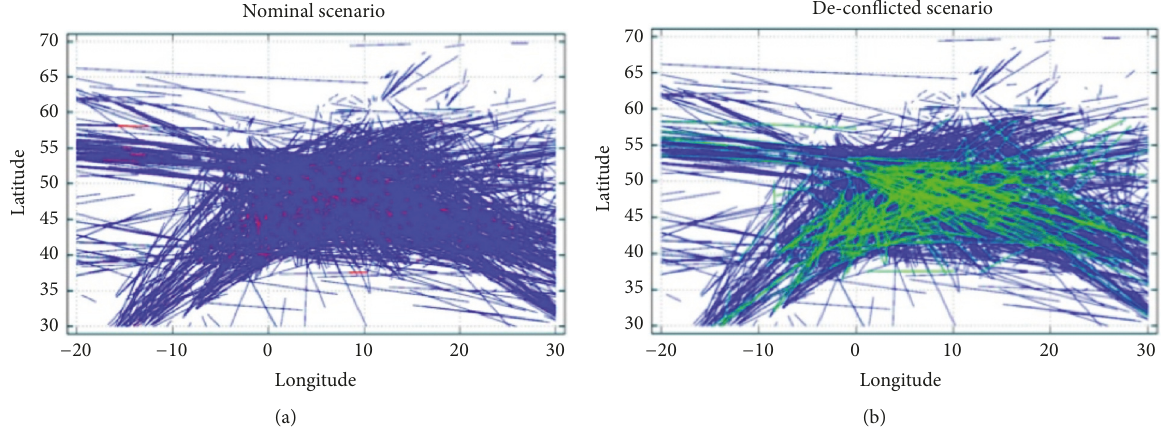
Figure 4: Nominal scenario of a single free-route airspace in ECAC, including 4010 UP4DTs (in blue) and producing more than 300 potential conflicts colored in red (a) and the same scenario globally deconflicted with 283 trajectory amendments colored in green (b).